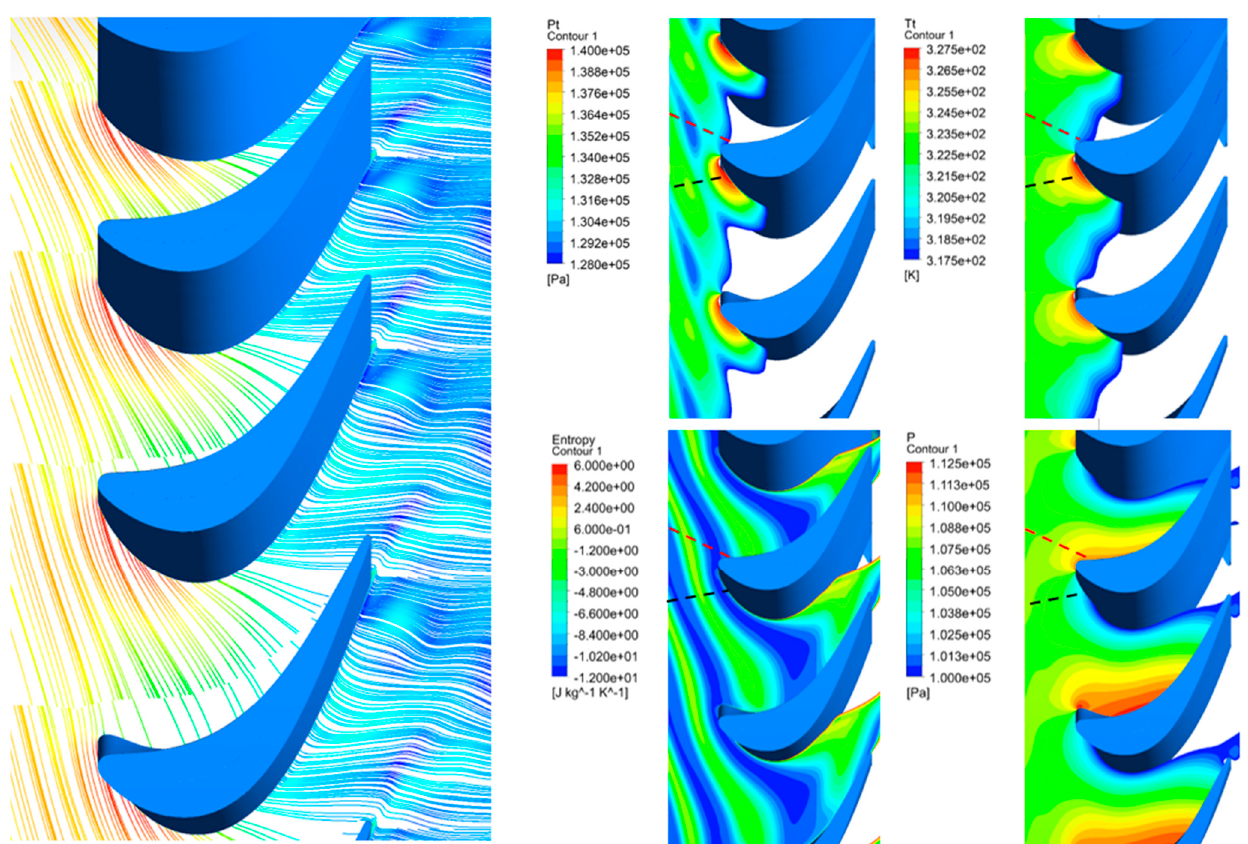
Figure 12. Computed instantaneous absolute flow field across the rotor at midspan. Left: streamlines of absolute velocity vector (coloured by the velocity magnitude). Center: Pt ( top ) and entropy ( bottom ) fields. Right: Tt ( top ), P ( bottom ) fields.